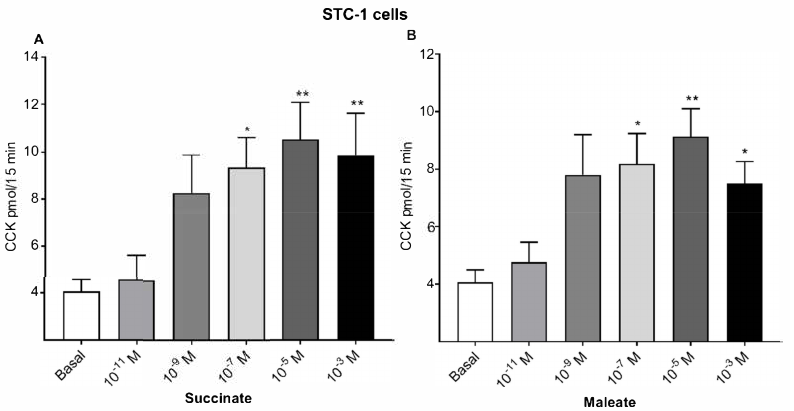
Figure 2. Dose responses of succinate and maleate in the enteroendocrine cell line STC-1. CCK release from STC-1 cells by succinate ( A ) and maleate ( B ). Succinate and maleate doses dependently stimulated CCK release from duodenal mucosal cells. CCK was measured in a bioassay and is expressed as a CCK release / 15 min collection period. Results were expressed as mean ± SEM, n = 8. * p < 0.05, ** p < 0.01, compared with basal values.